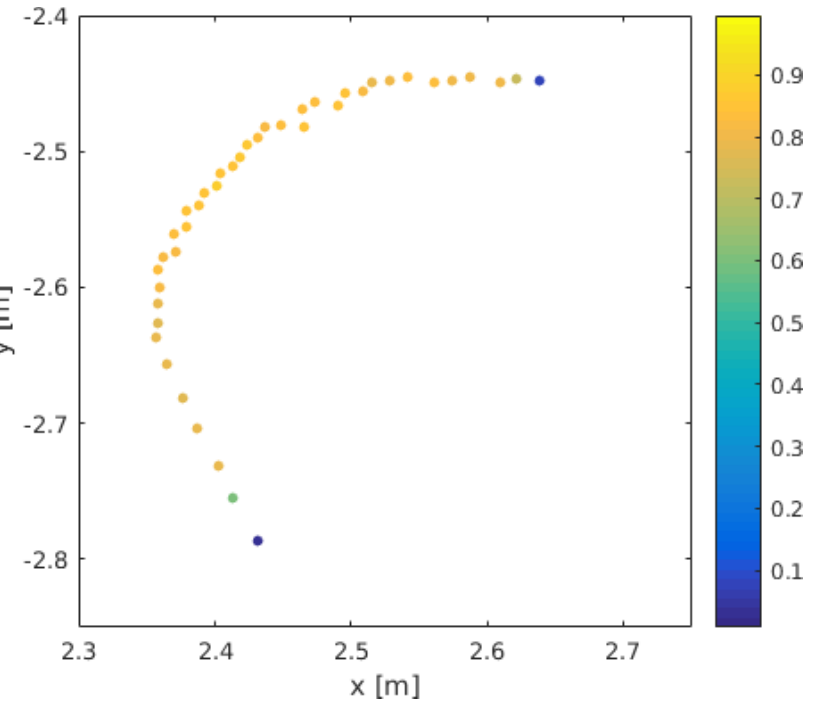
Figure 9. Edge points. A stem point cluster where the end points have lower intensity (blue). The blue points do not lie on the same circle as the yellow ones; they are slightly outside.